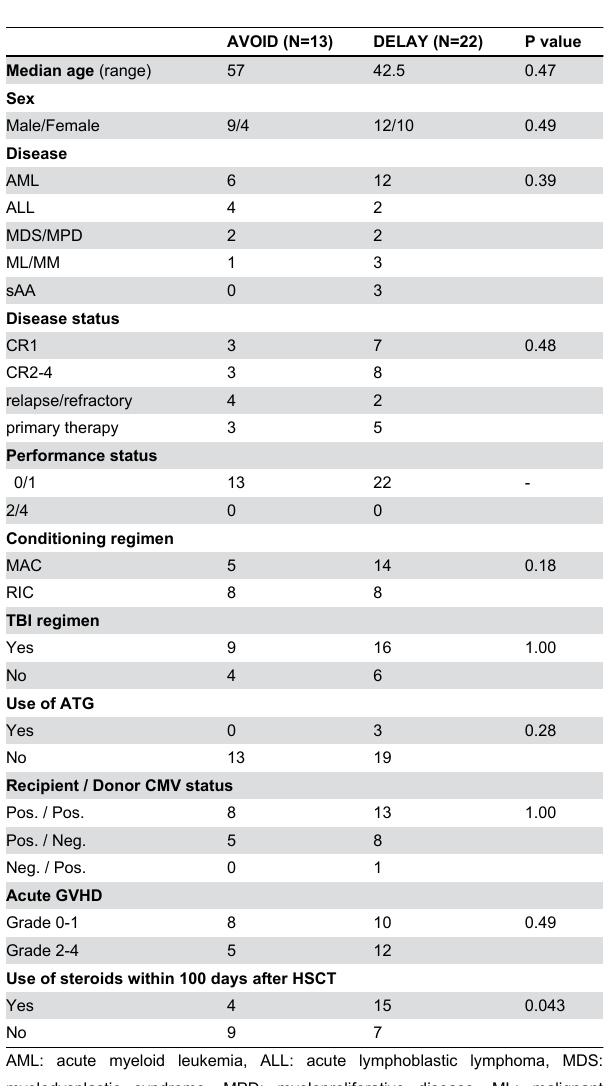
Table 3. Patient characteristics in the AVOID group and the DELAY